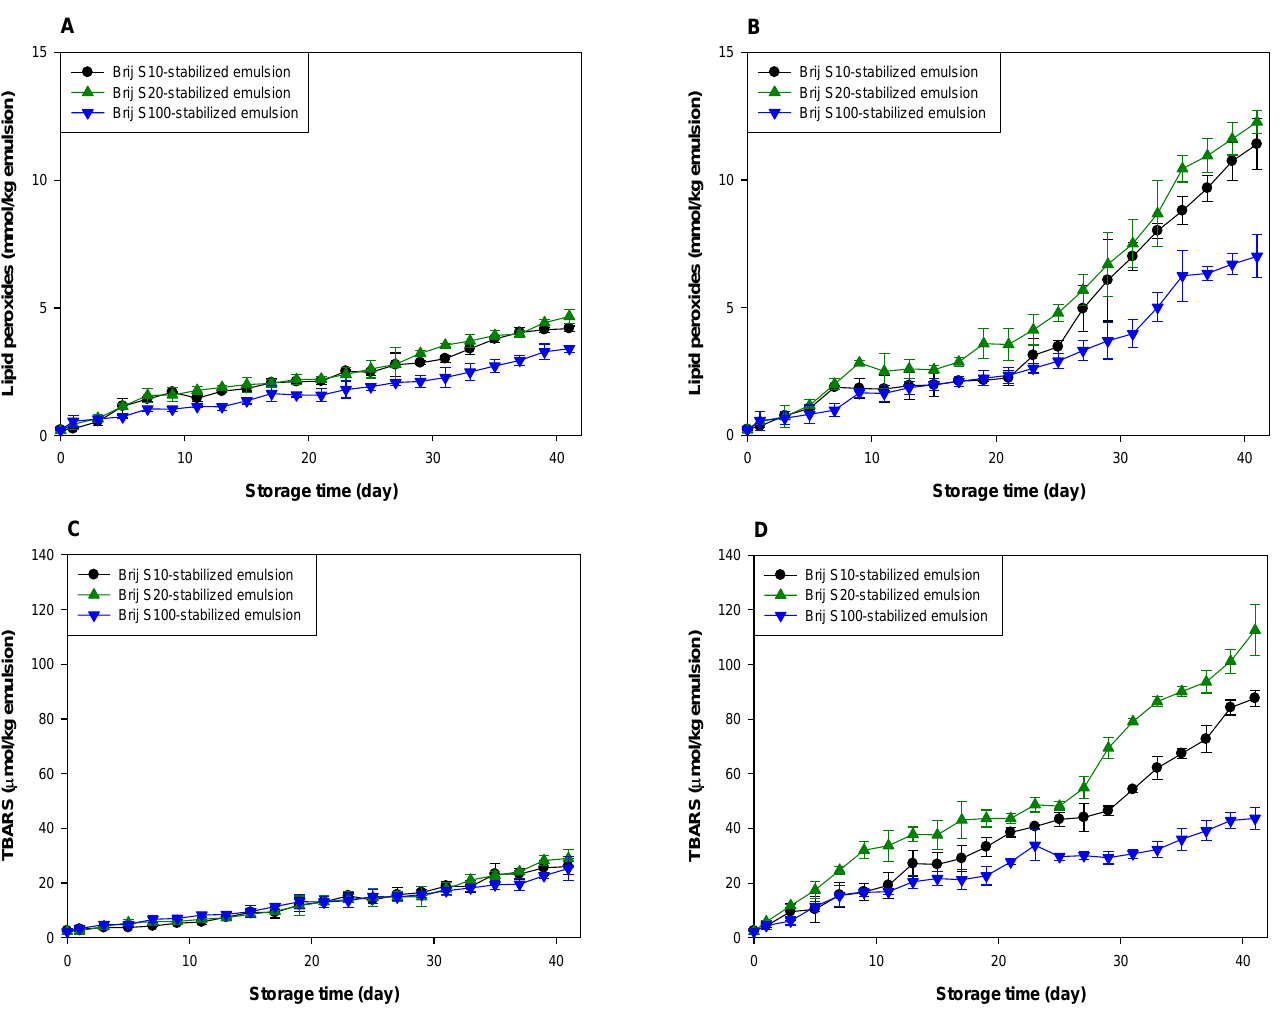
Figure 1. Formation of lipid peroxides (( A ) and ( B )) and TBARSs (( C ) and ( D )) in emulsions (5% ( w / w ) menhaden oil) stabilized with Brij surfactants during storage at pH 7 (( A ) and ( C )) and 3 (( B ) and ( D )).